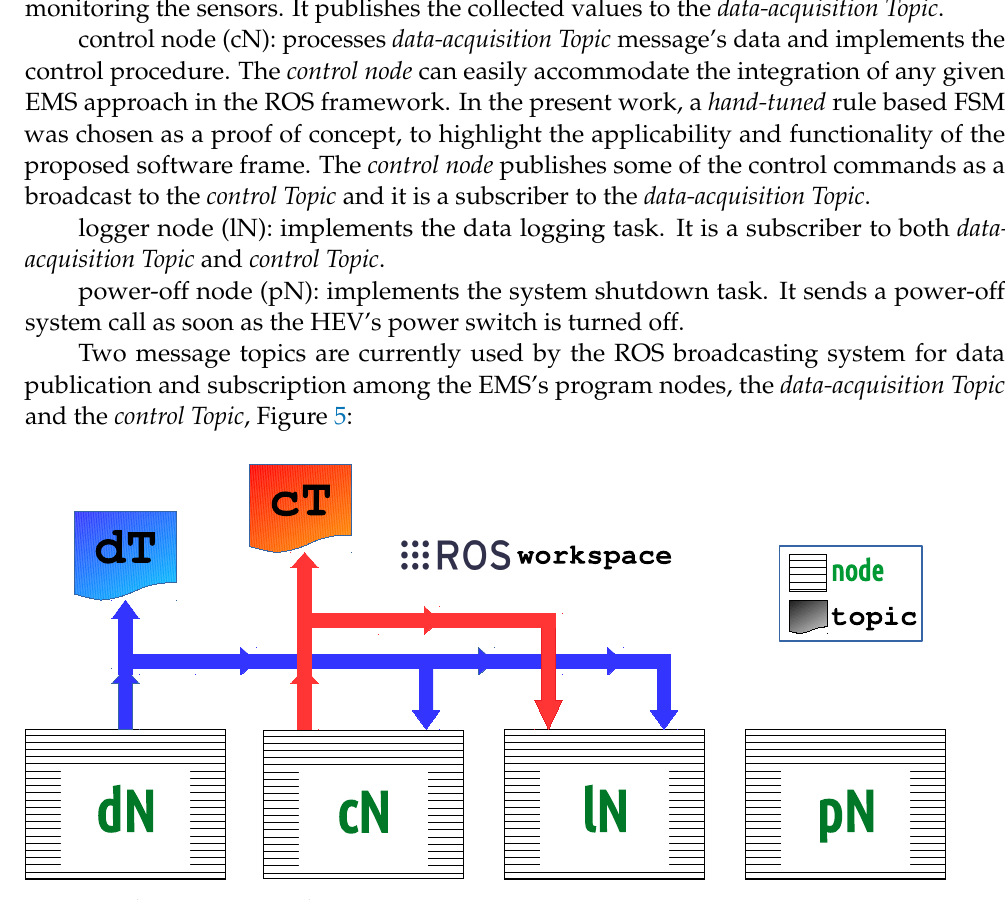
Figure 5. The EMS ROS